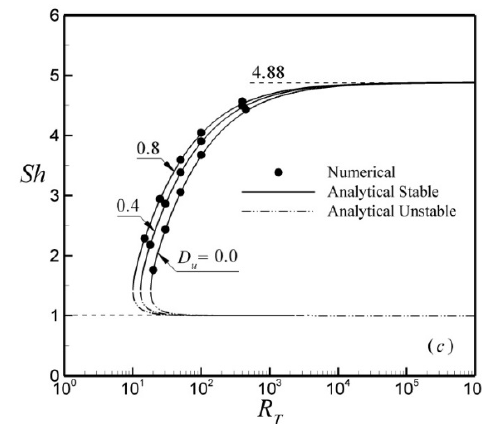
R and D for 4 10 Figure 9. Bifurcation diagram as a function of Da − = , 2 Le = , 0 ξ= and Figure 9. Bifurcation diagram as a function of R T and D u for Da e = 10 − 4 , Le = 2, ξ = 0, and ε = 1: T u e Ψ , ( b ) local Nusselt number, Nu , and ( c ) local Sherwood number, Sh . 1 ε = : ( a ) flow intensity, ( a ) flow intensity, Ψ 0 , ( b ) local Nusselt number, Nu , and ( c ) local Sherwood number, Sh . 0 The effects of the Soret and Dufour parameters on the evolution of the subcritical Rayleigh number with the Lewis number are illustrated in Figure 10 for the case of a monocellular flow. These results were evaluated from the analytical nonlinear theory model by searching numerically for the value of R 0 for which the inverse of the derivative T of Ψ 0n with respect to R 0 is equal to zero. Figure 10a,b indicate that, for a given value of T the Soret and Dufour parameters, R sub ,0 TC